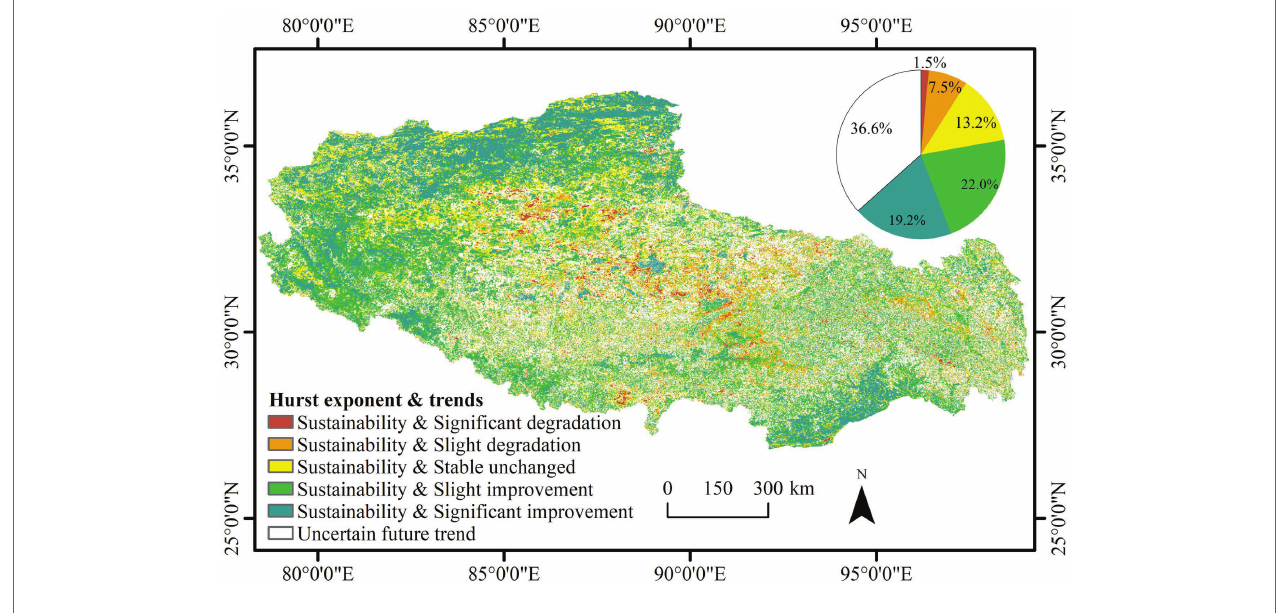
FIGURE 7 | Spatial distribution of the NDVI trends based on the Hurst exponent.